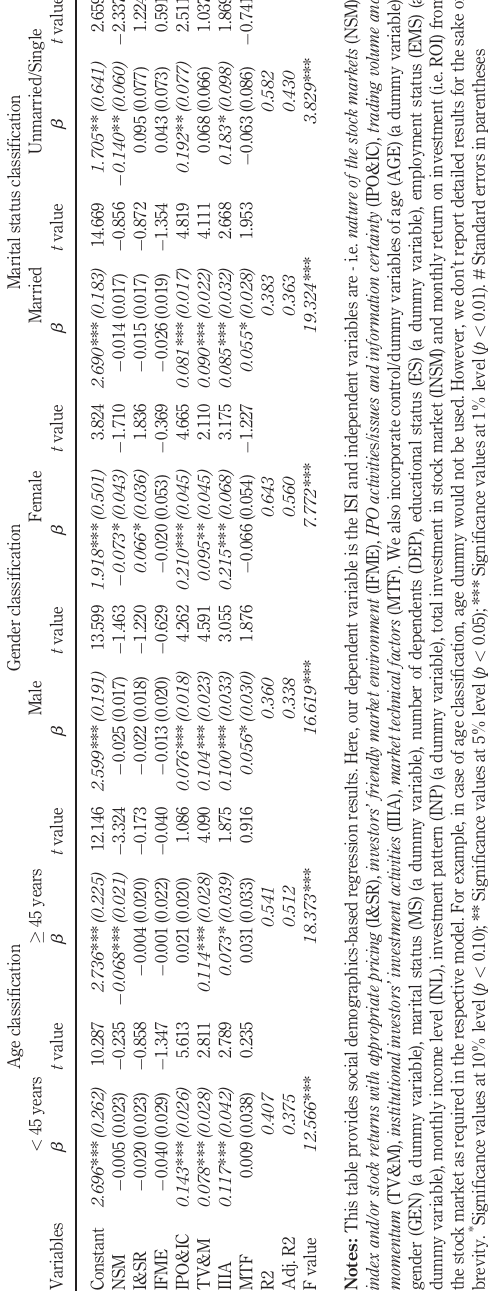
Table 4. Regression results (social